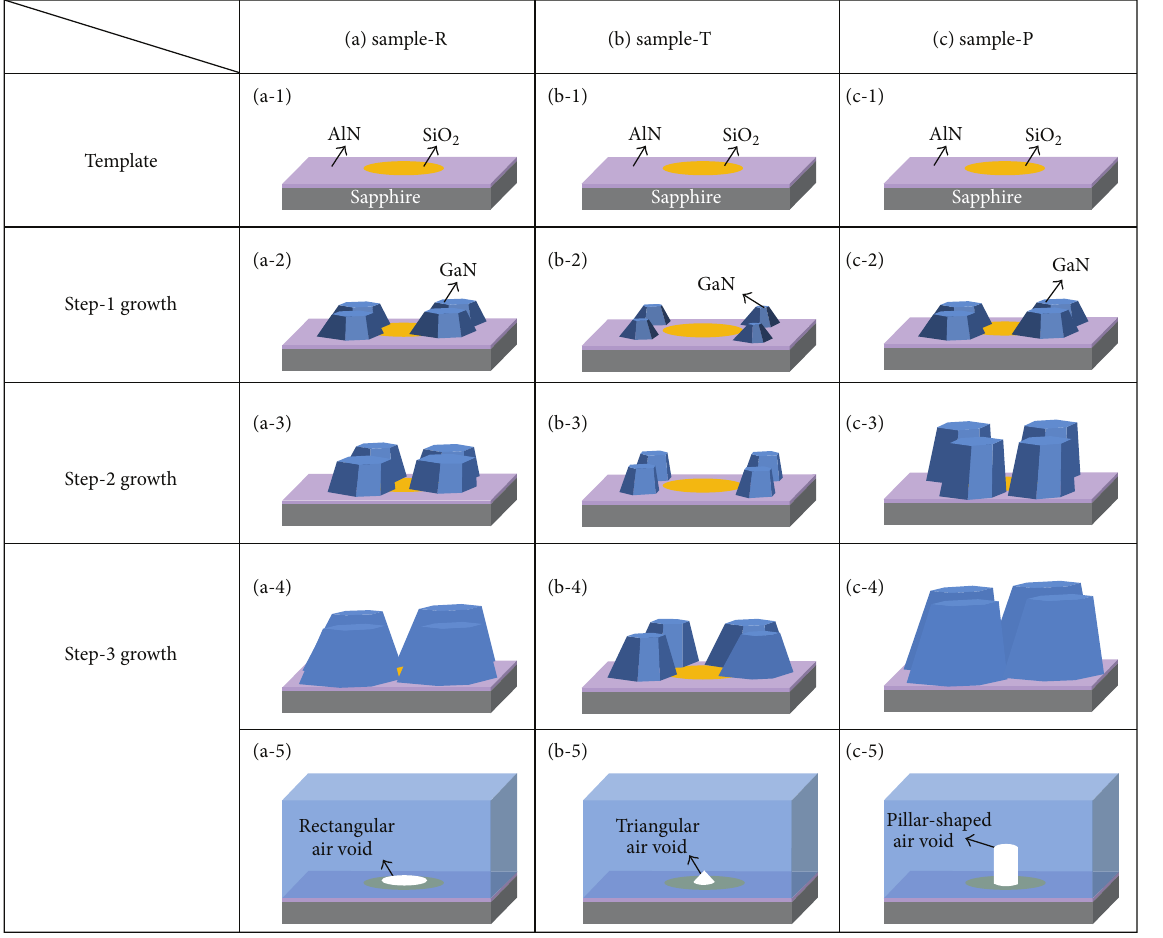
Figure 3: The proposed growth model of (a) sample-R, (b) sample-T, and (c) sample-P.